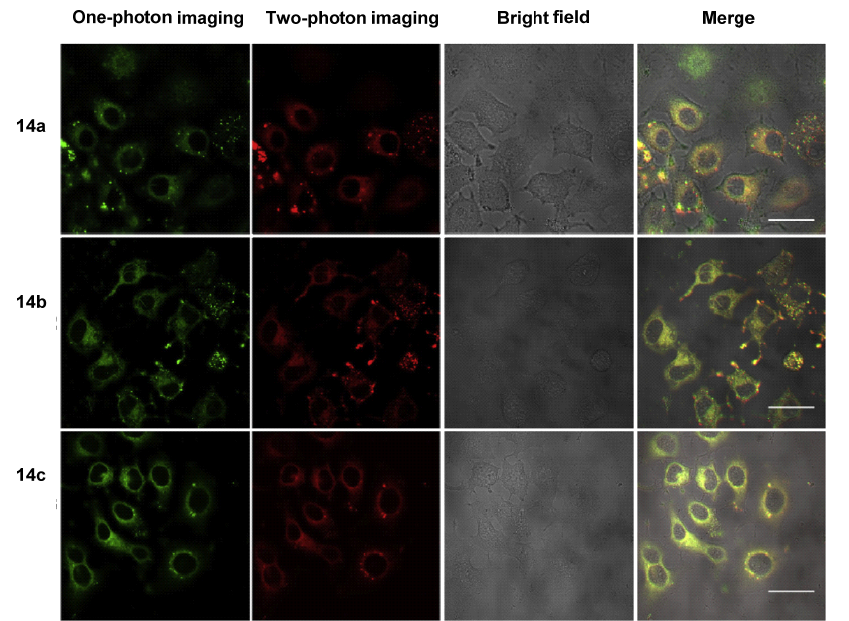
Figure 12. One- and two-photon imaging of HepG2 cells stained with terpyridine derivatives 14a – c . Adapted from [40].